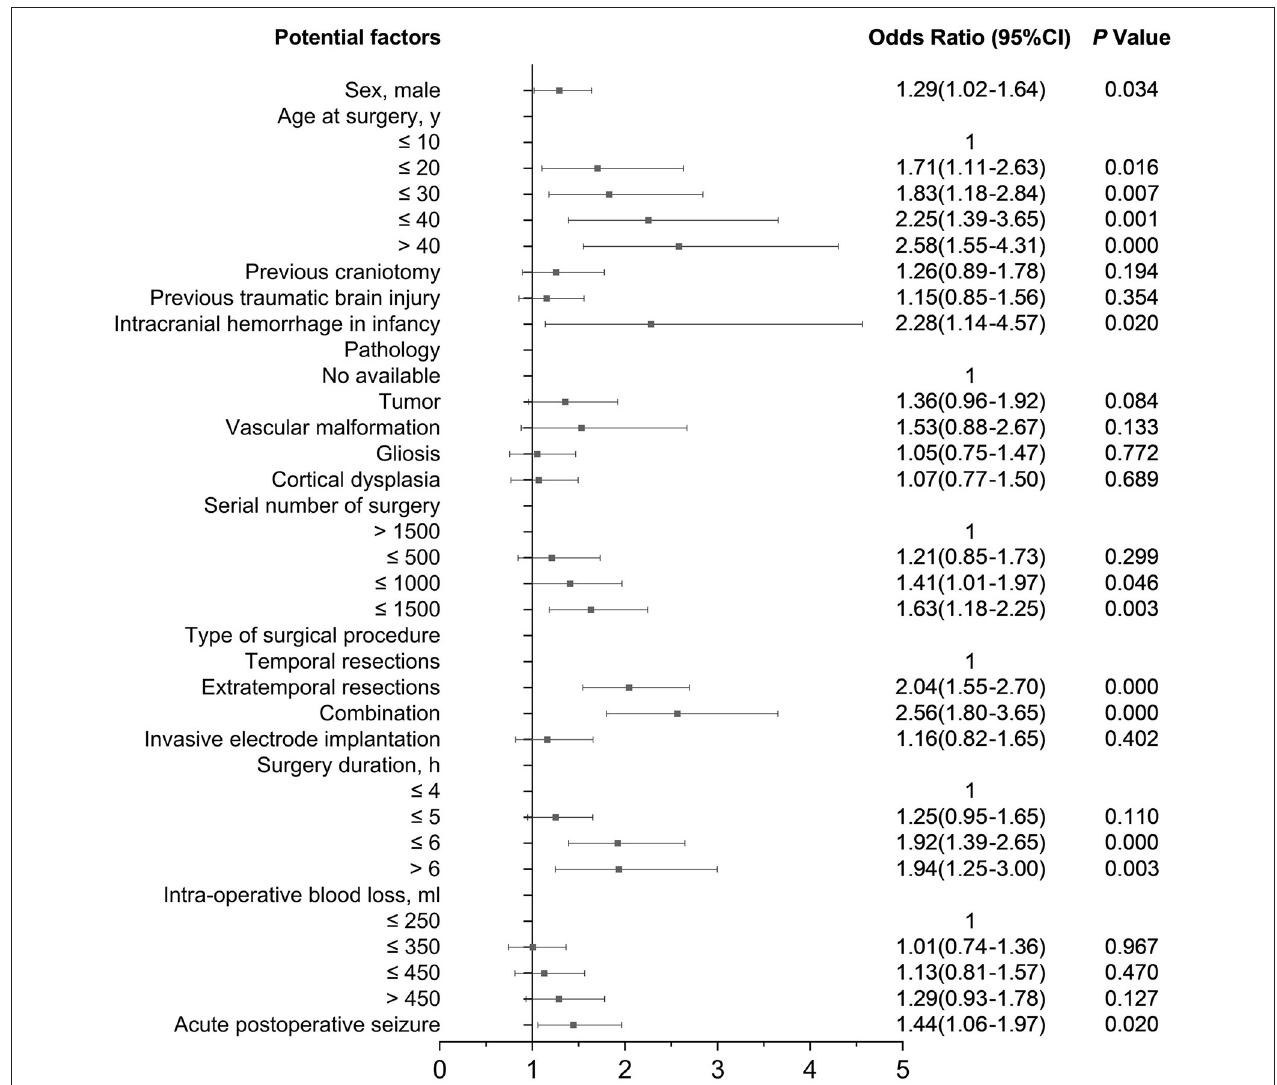
FIGURE 2 | Risk factors for complications in multivariate